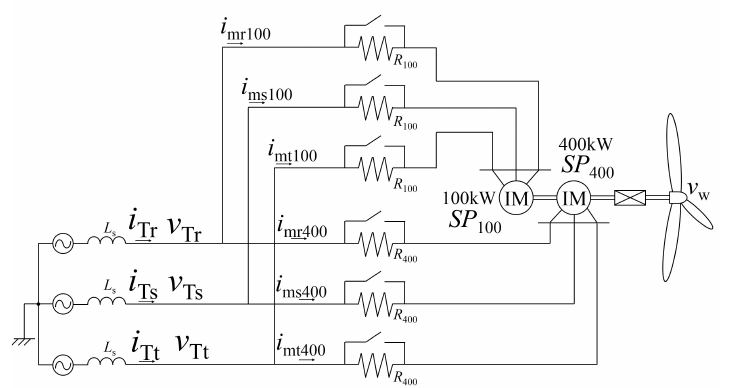
Figure 11. System configuration with external resistors.